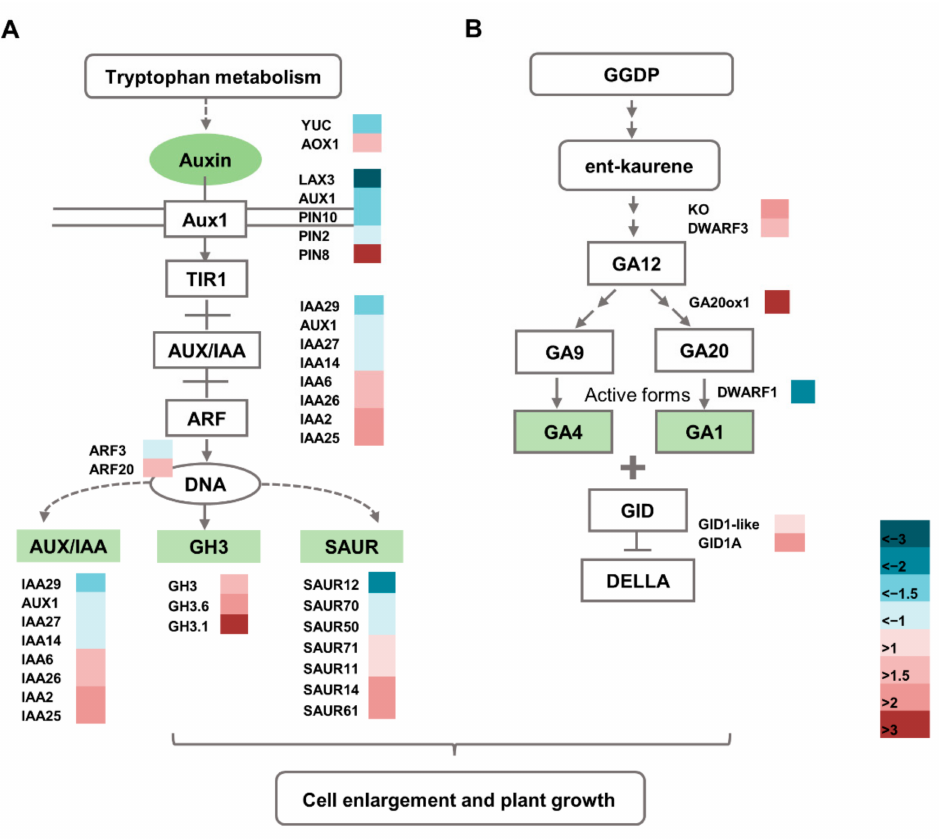
Figure 13. DEGs involved in phytohormone biosynthesis and signaling. ( A ) DEGs involved in auxin biosynthesis and signaling. ( B ) DEGs involved in gibberellin synthesis and signaling. On the log 2 scale, dark blue and dark red colors represent lower and higher expression,